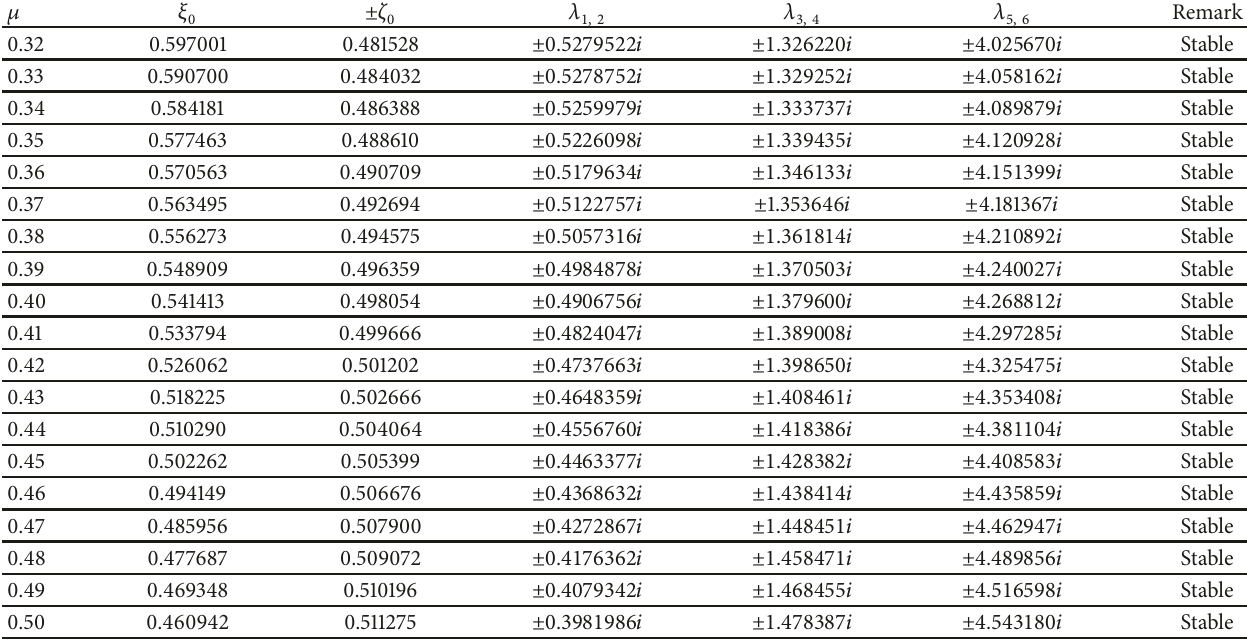
Table 8: Effects of mass ratio 𝜇 on the locations and stability of out-of-plane points for 𝑎 = 0.95, 𝑒 = 0.2, 𝑞 2 = 0.9999, 𝐴 = 0.08, 𝜎 1 = 0.03 and 𝜎 = 2